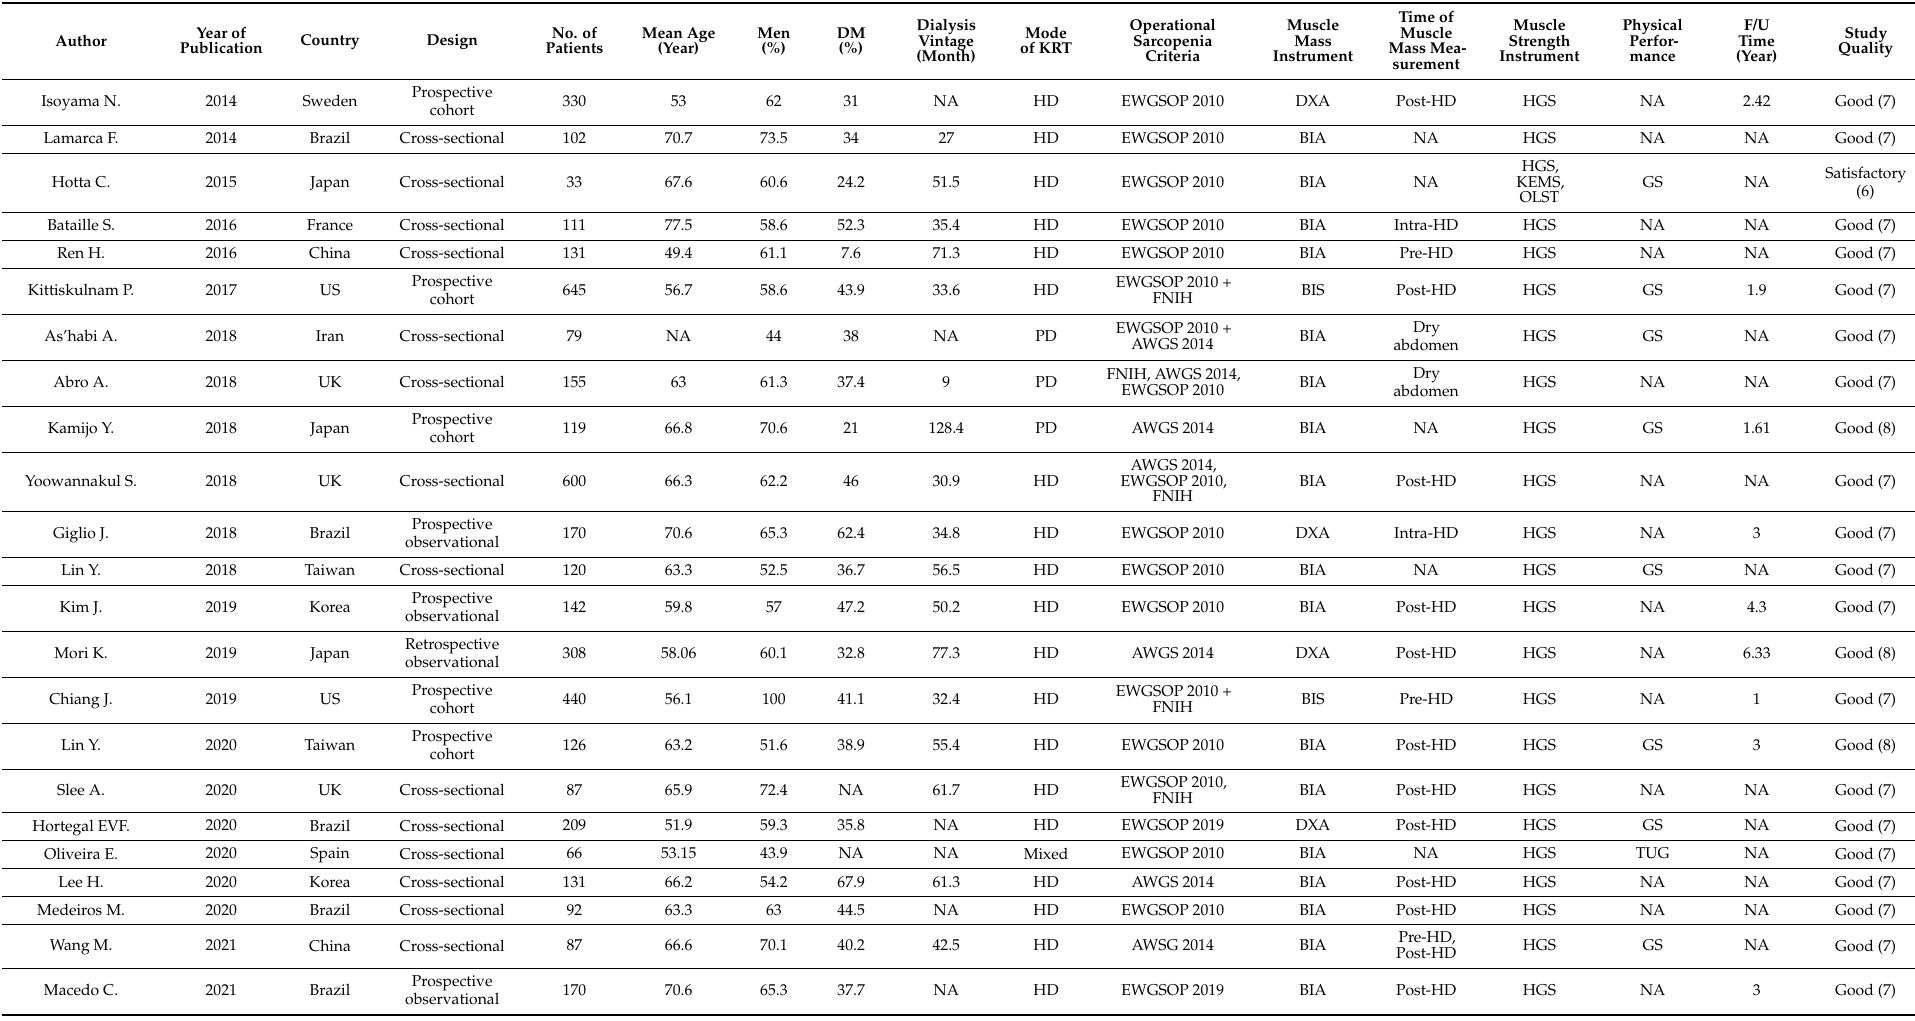
Table 1. Characteristics of the studies included in the systematic